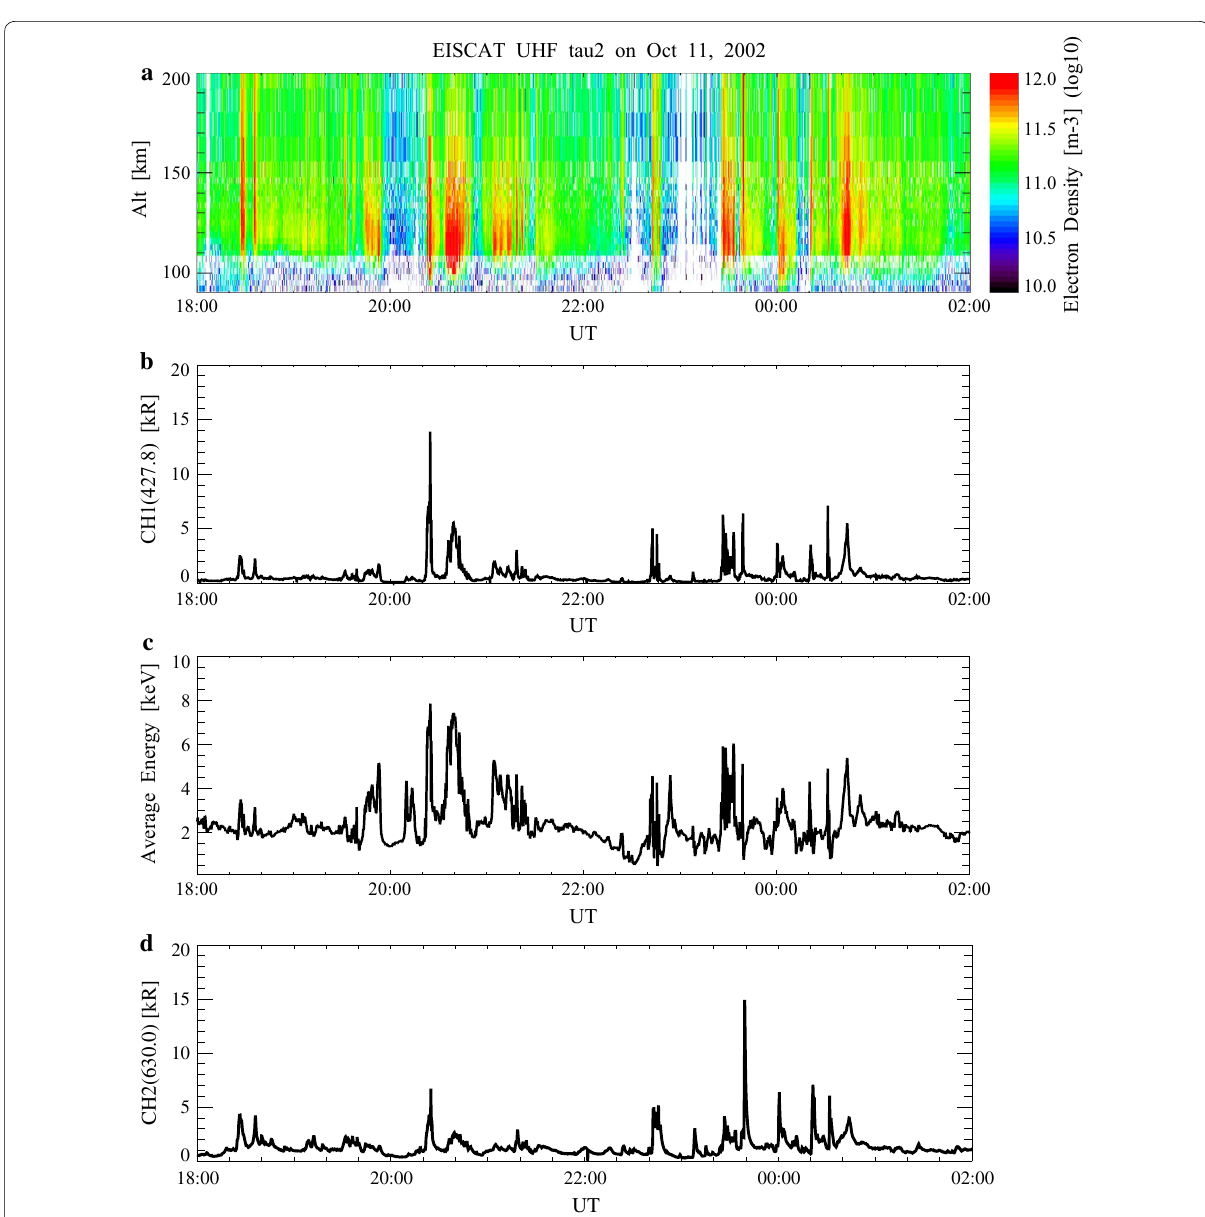
Fig. 7 EISCAT and photometer results for October 11, 2002; the same as Fig. 2 except for the period from 18:00 UT on October 11 to 02:00 UT